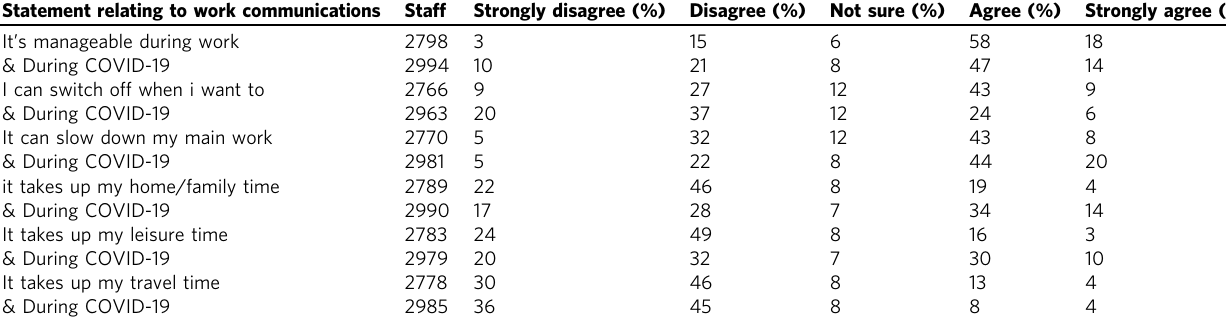
Table 2 Survey Section 4: impact of digital communications on work and work-life balance. Statement relating to work communications